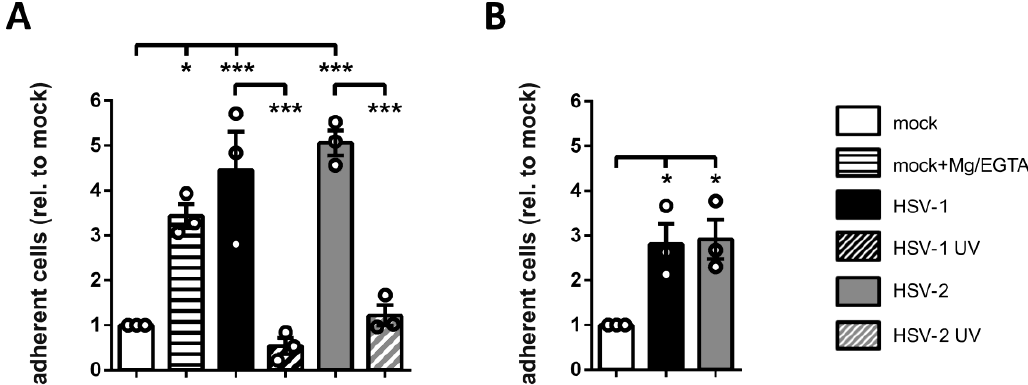
Figure 6. HSV-2 induces fibronectin and ICAM-1 adhesion of mDCs. ( A ) Mock- (white bars), HSV-1- (MOI of 2, black filled bars), HSV-1 UV- (MOI of 2; 8 × 0.12 J/cm 2 , black striped bar), HSV-2- (MOI of 5; gray filled bars), or HSV-2 UV-infected (MOI of 5; 8 × 0.12 J/cm 2 , gray striped bar) mDCs were harvested 4 hpi. Mock controls were treated with or without Mg/EGTA. Cells were allowed to adhere on fibronectin-coated wells for 45 min. ( B ) Mature DCs were mock- (white column), HSV-1- (MOI of 2, black column), or HSV-2-infected (MOI of 5, gray column) and harvested 24 hpi. Cells were allowed to adhere to ICAM-1-Fc coated plates for 45 min. ( A , B ) Input conditions as well as adherent cells were quantified by measuring the β-glucuronidase activity. Changes in mDC adherence are shown relative to the mock condition (set to “1”).The experiment was performed three times with cells from different healthy donors, while each single condition was performed in quadruplicates. Error bars indicate ± SEM. Significant changes are marked by asterisks (*** = p < 0.001; * p < 0.05).